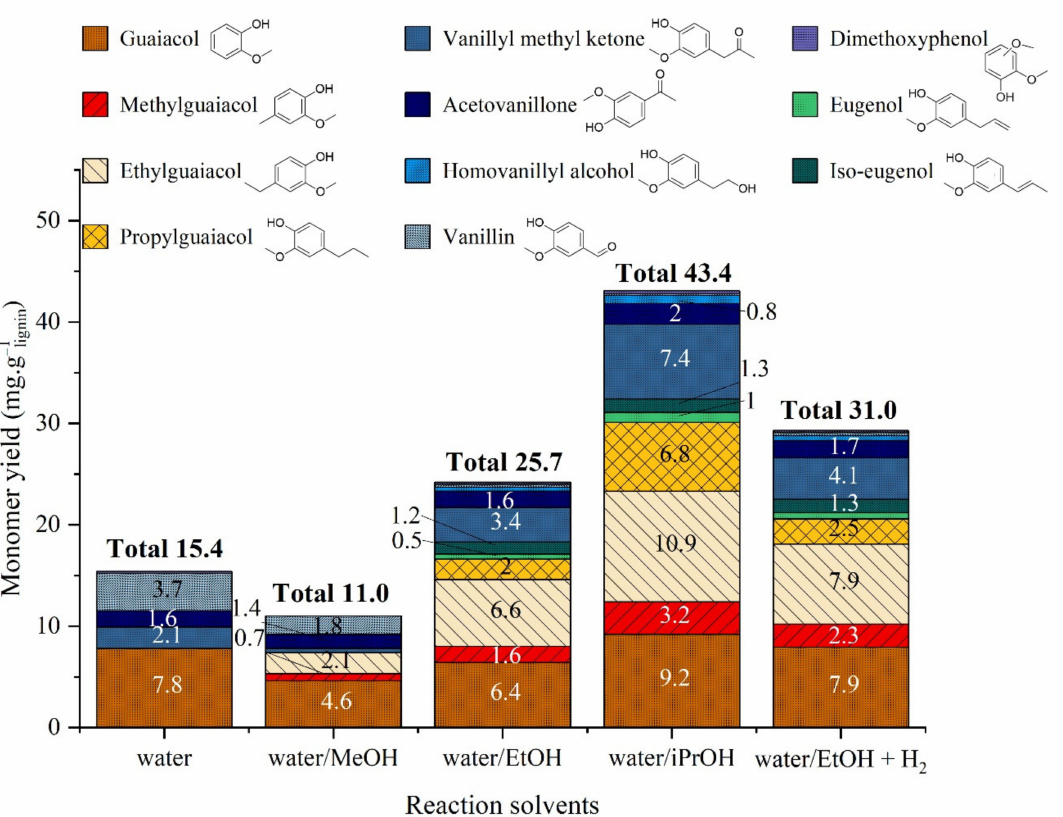
Figure 12. Yield of monomeric products in organic phase after catalytic lignin liquefaction in water/alcohol mixtures over Pd/ZrO 2 . Reaction conditions: Kraft lignin 10 g · kg − 1 , mass ratio Pd/lignin 0.6/100, 3 h, 225 ◦ C, 40 bar